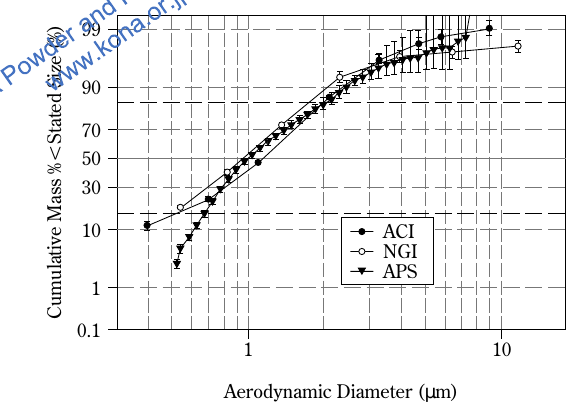
Close agreement in TOF- and cascade impactor-mea- sured particle size distributions for a solution formulation (Qvar™, 3M Pharmaceuticals) containing no surfactant (from [87]: used by permission, AAPS PharmSciTech